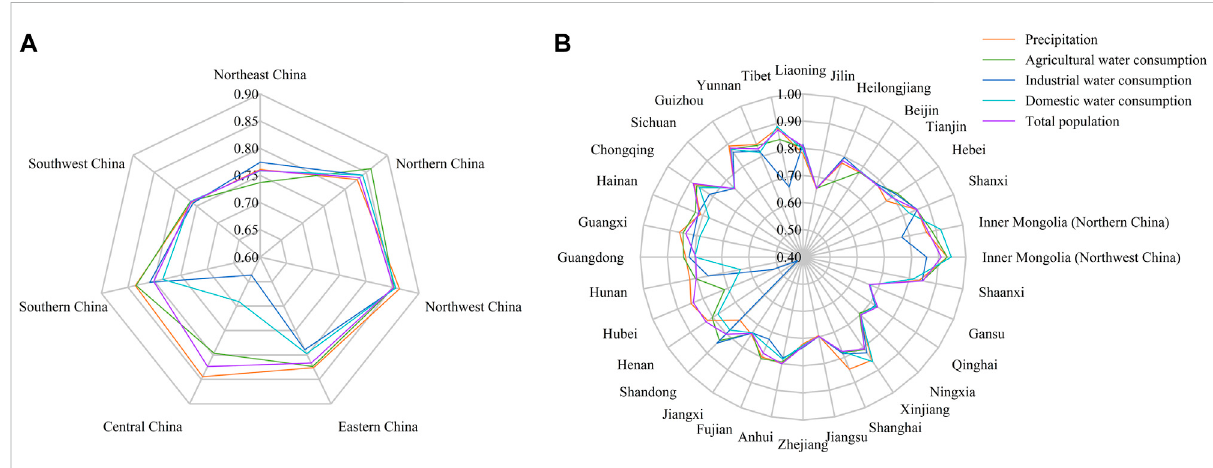
FIGURE 8 Main drivers of regional and provincial GWS change. (A) Regional scale. (B) Provincial